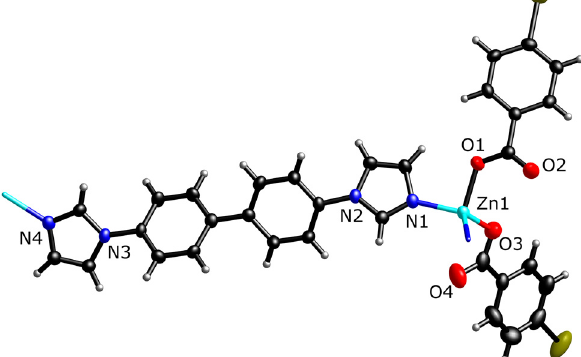
Table 1 contains crystallographic data and Table 2 contains the list of the atoms including atomic coordinates and displacement parameters.